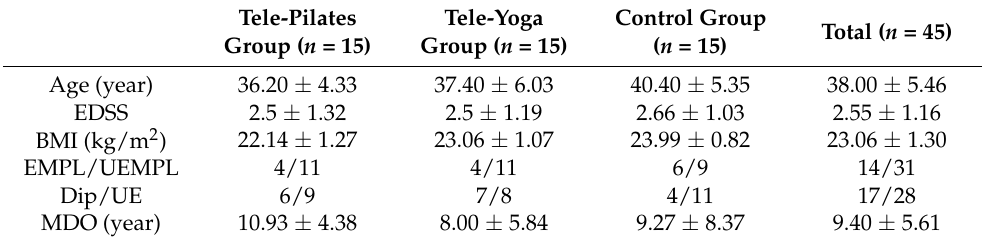
Figure 1. Participants’ flow in an 8-week tele-exercising program. Table 1. Demographic characteristics of female participants.